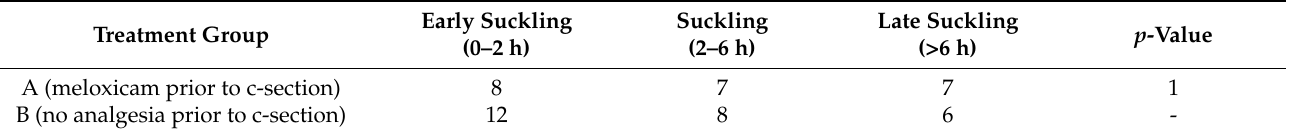
Table 2. Distribution of the calves according to the delay between the end of the surgery and the first colostrum spontaneous suckling by the calf as observed by the farmer.